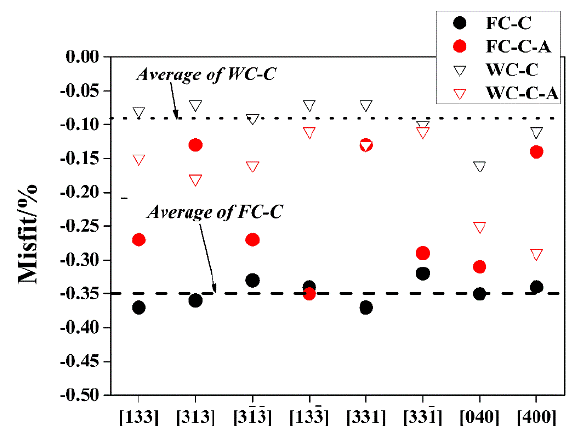
Figure 6. The mismatches of some crystal faces of the {331} and {004} family of crystal planes for the samples FC-C and FC-C-A.